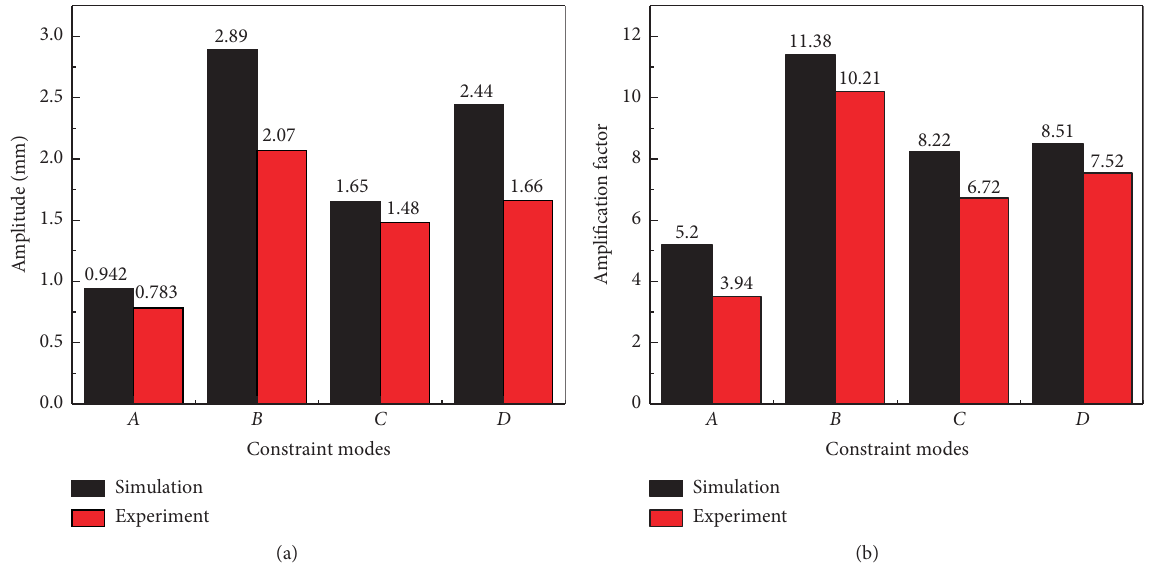
Figure 8: Amplitude and amplification factor of disc spring system with 10 springs under different constraint modes: (a) amplitude and (b) amplification factor. A , B , C , and D refer to no locking and no preloading, locking and no preloading, amount of preload compression being less than twice the amplitude, and amount of preload compression being more than twice the amplitude,